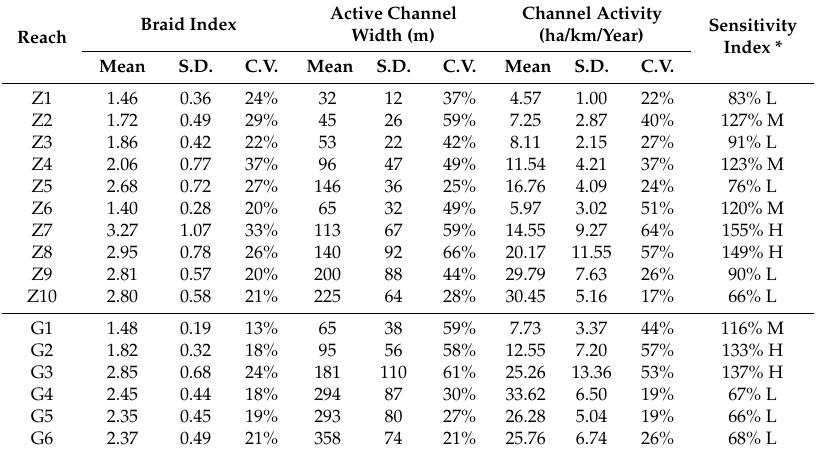
Table 3. Sensitivity index and statistics of braid index, active channel width, and channel activity for study reaches.